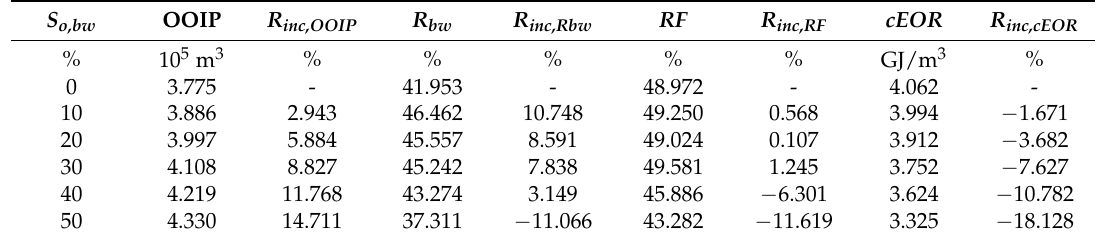
Table 4. Simulation results for different oil saturations in the bottom water